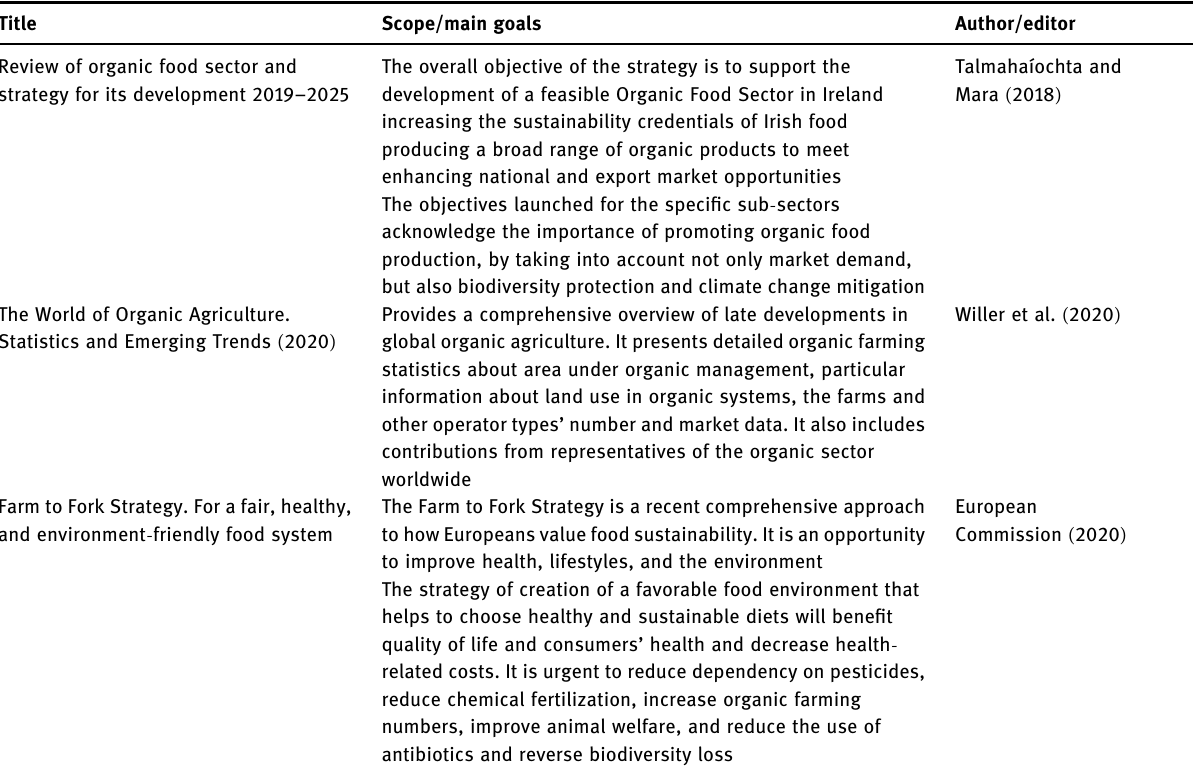
Table 2: Publications focused on organic agriculture: Recent and future